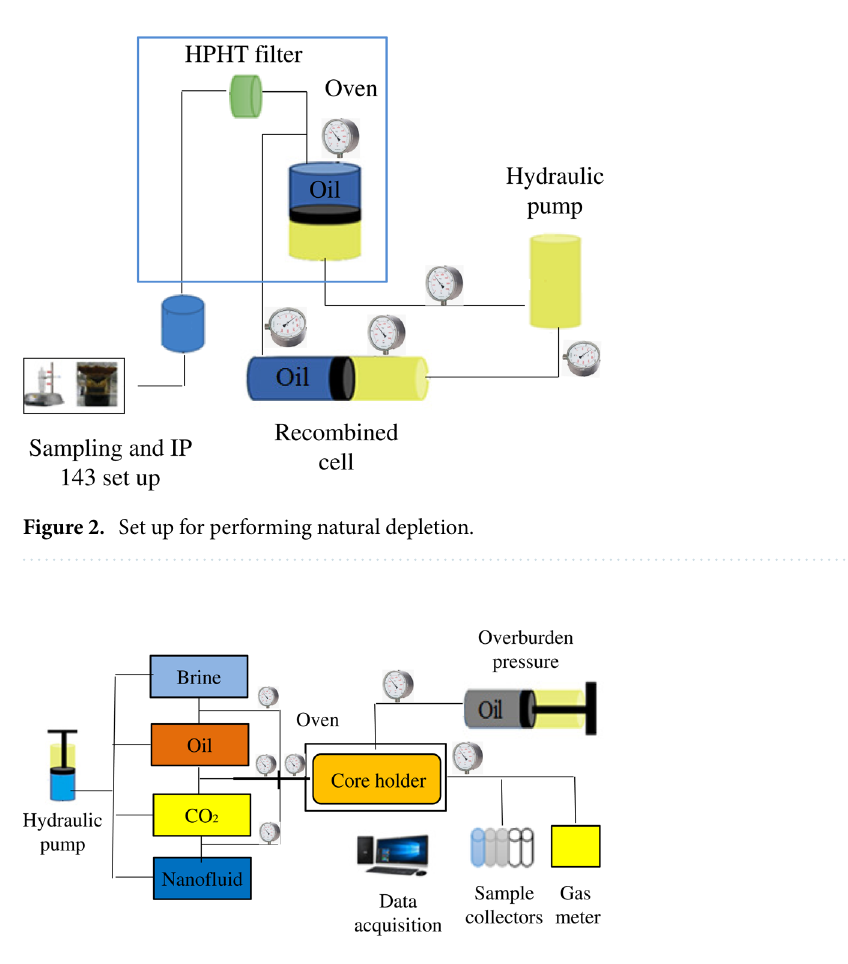
Figure 3. Dynamic apparatus for performing dynamic CO 2